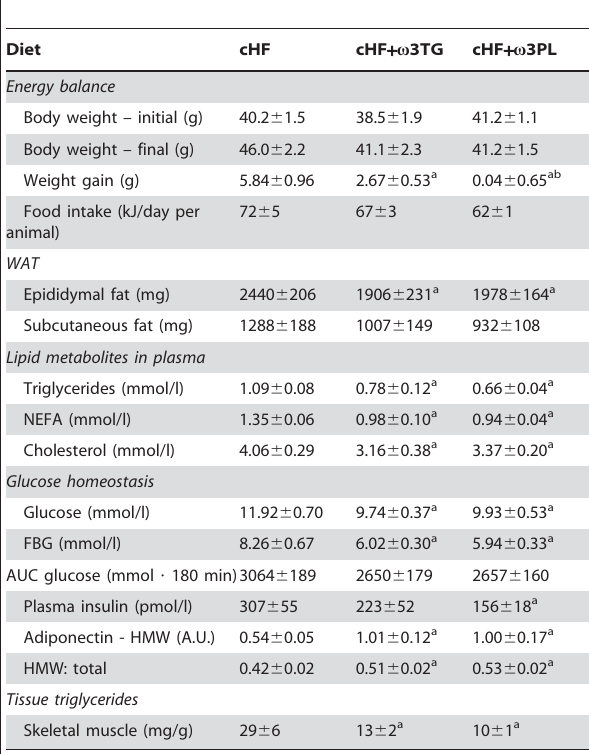
Table 2. Reversal of obese phenotype by dietary LC n -3 PUFA administered as either triglycerides or